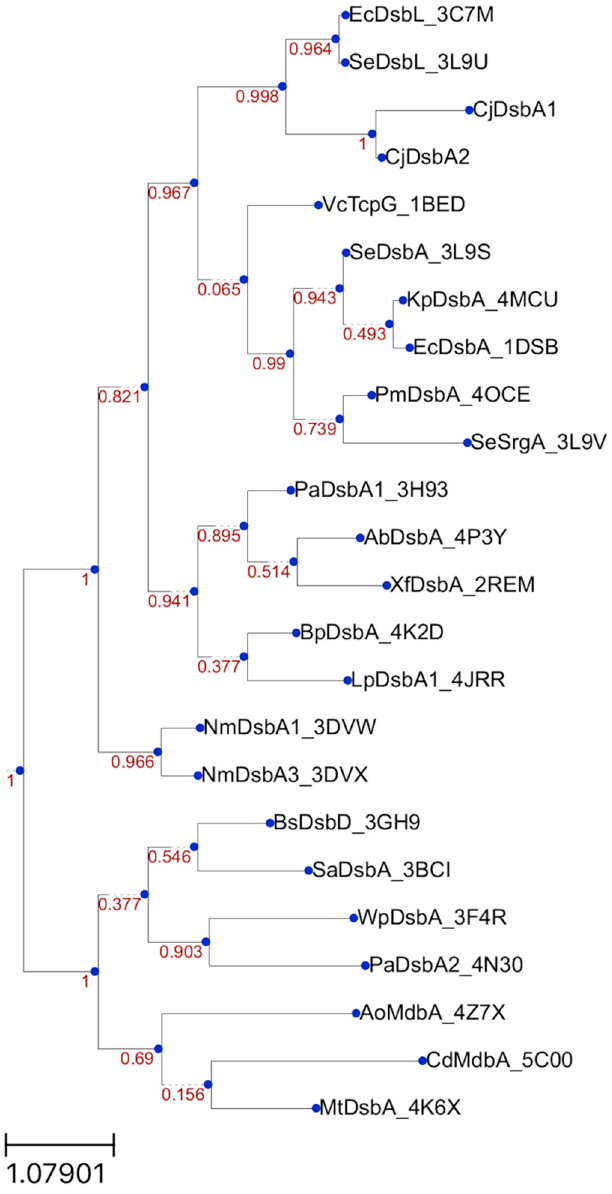
Figure 14. Phylogenetic tree calculated for a representative set of Dsb proteins obtained from Totsika et al. [6], and DsbA1 and DsbA1 from C. jejuni . Sequence names are accompanied by respective Protein Data Bank codes. Numbers near the branching points denote support values. The tree was calculated with the FastTree program and rooted using the midpoint method.